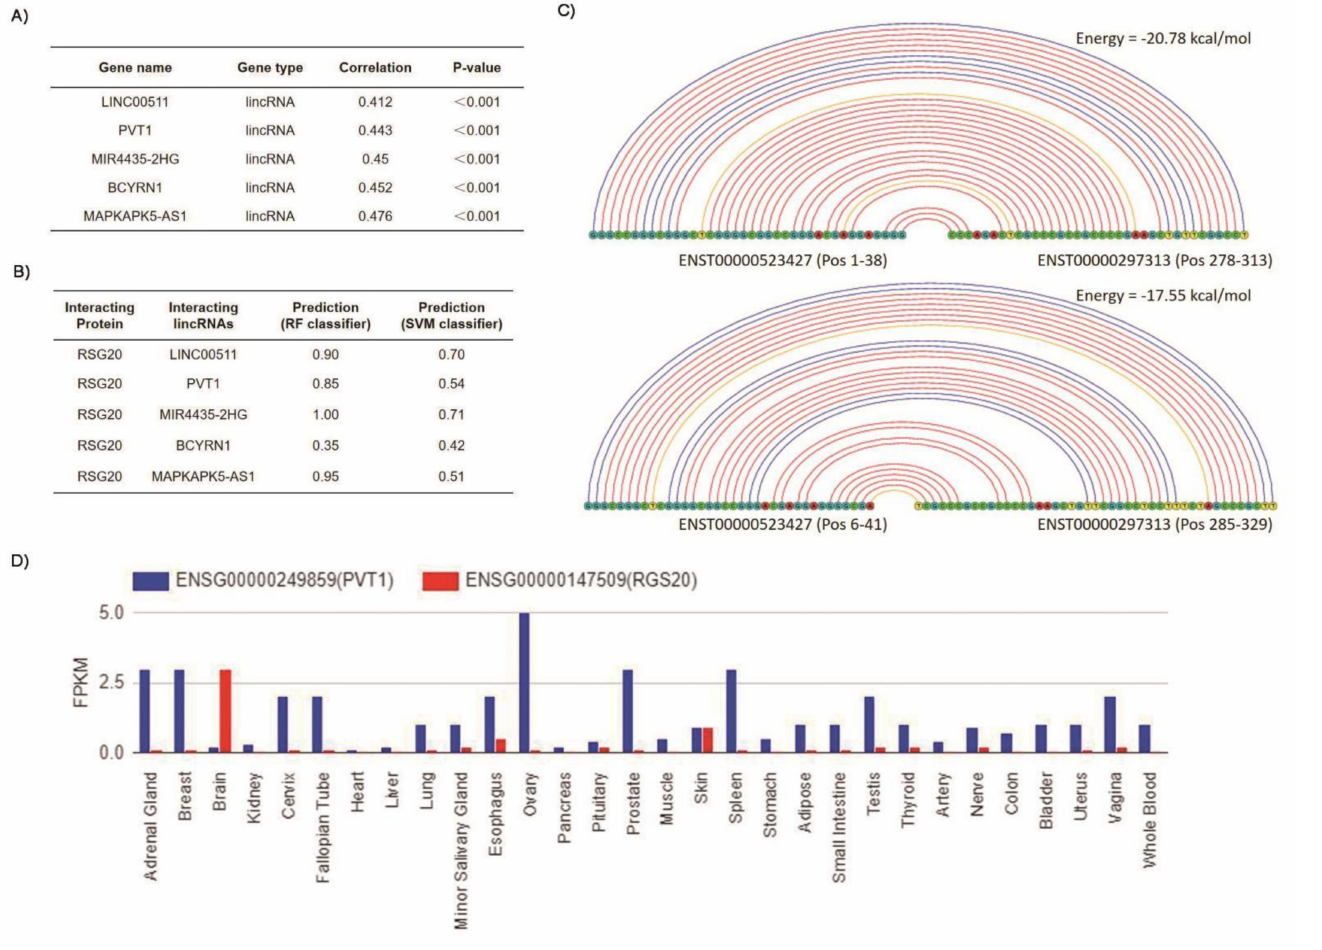
Figure 4. Prediction of RGS20 interaction with lincRNAs and gene expression in human tissues. ( A ) Correlation of RGS20 with five lincRNAs. ( B ) Interaction of five lincRNAs with RGS20 protein. ( C ) Two physical interactions of lincRNA PVT1 and mRNA of RGS20. ( D ) Gene expression level of the lincRNA PVT1 and the RGS20 mRNA in different tissues of